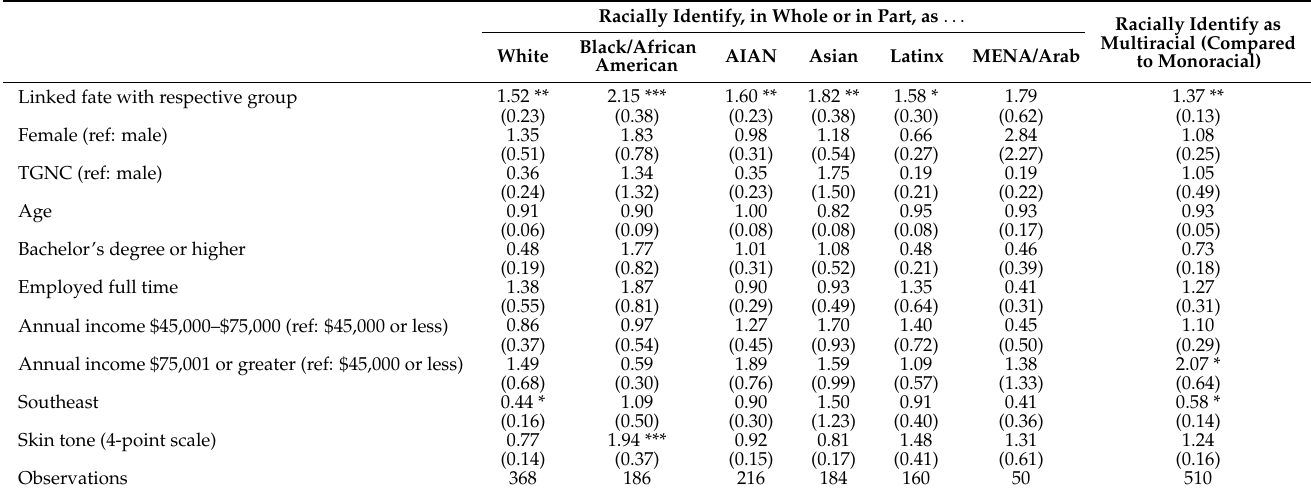
Multiracial (Compared to Monoracial)White